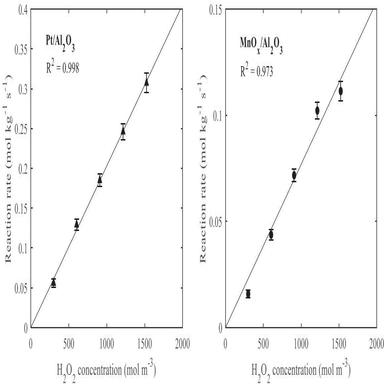
Reaction rate vs H2O2 concentration for platinum (Sigma-Aldrich, left) and manganese oxide (MnOx-1200–02, right). The correlation with a first-order rate law (linear fit) is shown.